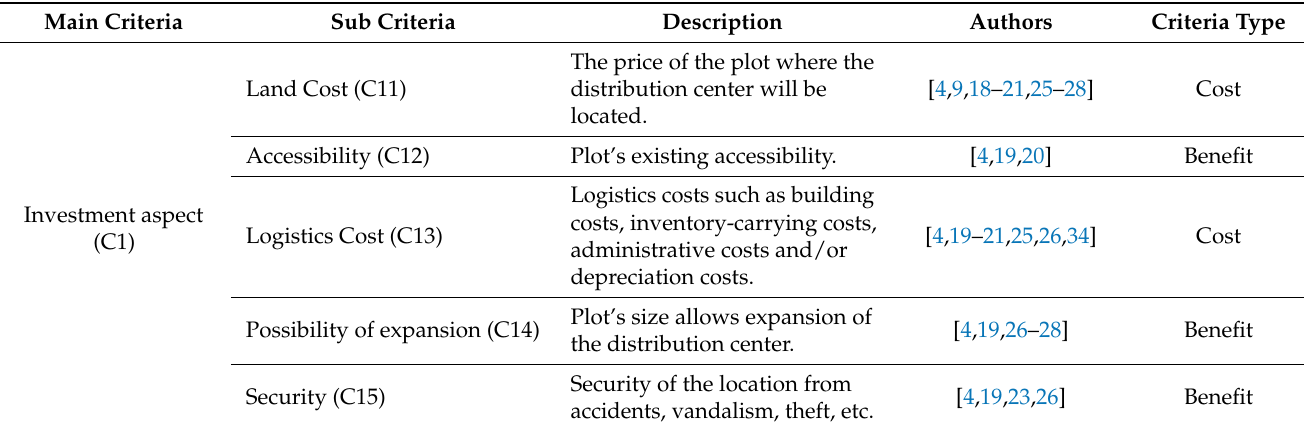
Table 1. Investment aspect: Criteria for selection of distribution center location.